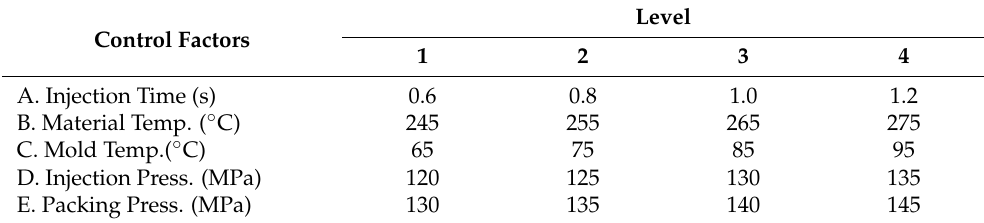
Table 4. Control Factors and